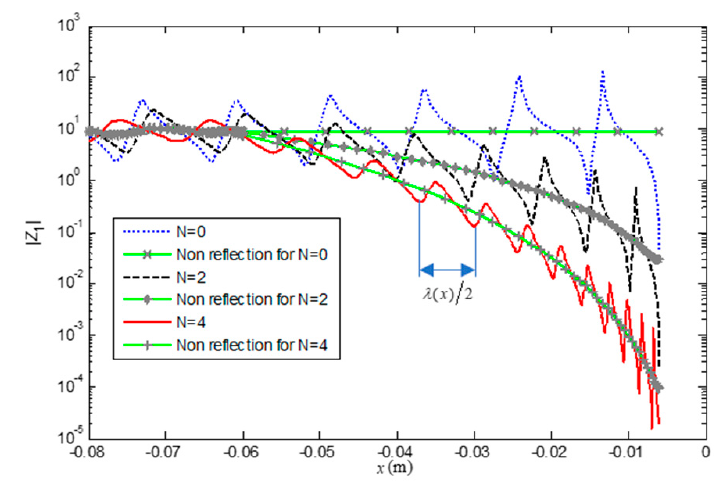
Figure 6. Scalar impedance Z 1 along x -axis.